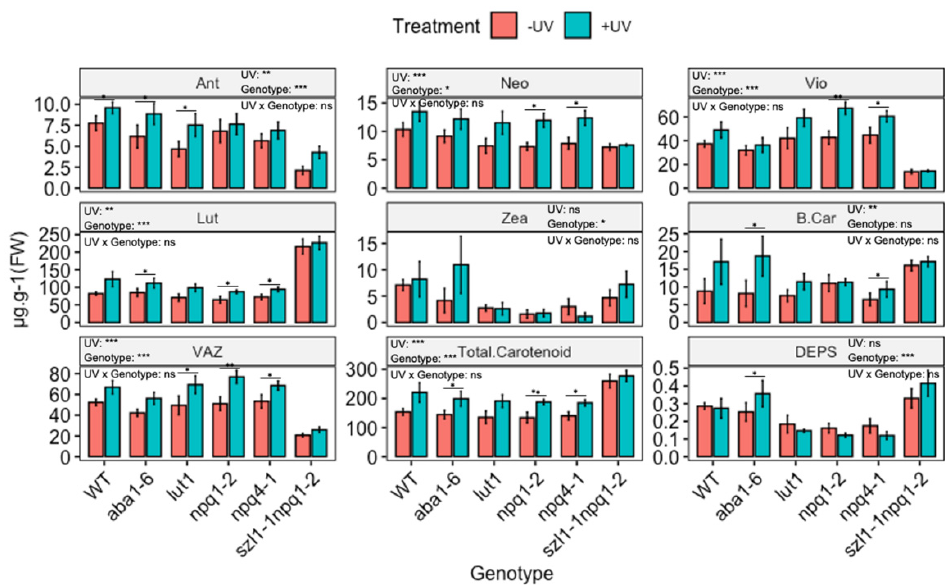
Figure 5. Carotenoid contents ( μ g·g − 1 FW, except DEPS) of wild-type (WT) and carotenoid biosyn- thesis ( aba1-6 , lut1 , npq1-2 , npq4-1 and szl1-1npq1-2 ) impaired Arabidopsis thaliana (Col-0). Plants were subjected to UV treatment for 3.75 h daily and harvested after 18 h on day 4. Bar plots show means and error bars indicate standard error for n = 5. The text in each panel shows the outcome of a two-way ANOVA across treatment and exposure duration. The stars above pairs of bars show the outcome of t -tests between the UV treatments. In both cases * ( p < 0.05), ** ( p < 0.01) and *** ( p < 0.001) depict significant differences with ns depicting a non-significant difference.